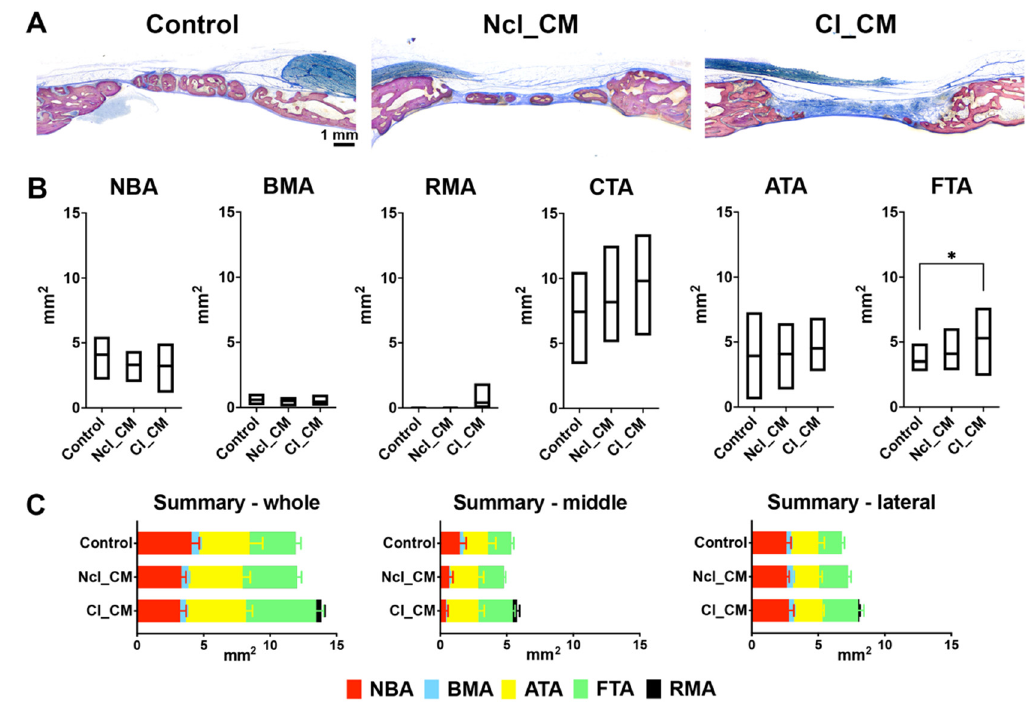
Figure 5. ( A ) Overviews of toluidine blue and fuchsin staining of the defect on the sagittal plane at three months post- surgery. ( B ) Histomorphometry of area parameters including new bone area (NBA, mm 2 ), bone marrow area (BMA, mm 2 ), residual material area (RMA, mm 2 ), connective tissue area (CTA, mm 2 ), adipose tissue area (ATA, mm 2 ), and fibrous tissue area (FTA, mm 2 ). * denotes significant difference between the groups; p < 0.05. ( C ) Summary of area parameters in whole